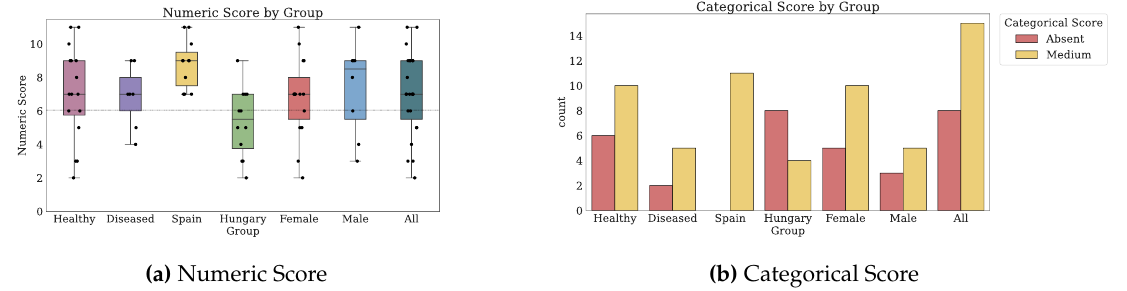
Figure A6. Scores for Mediterranean Nutrition (PREDIMED). Dotted markings delimit levels of the categorical score